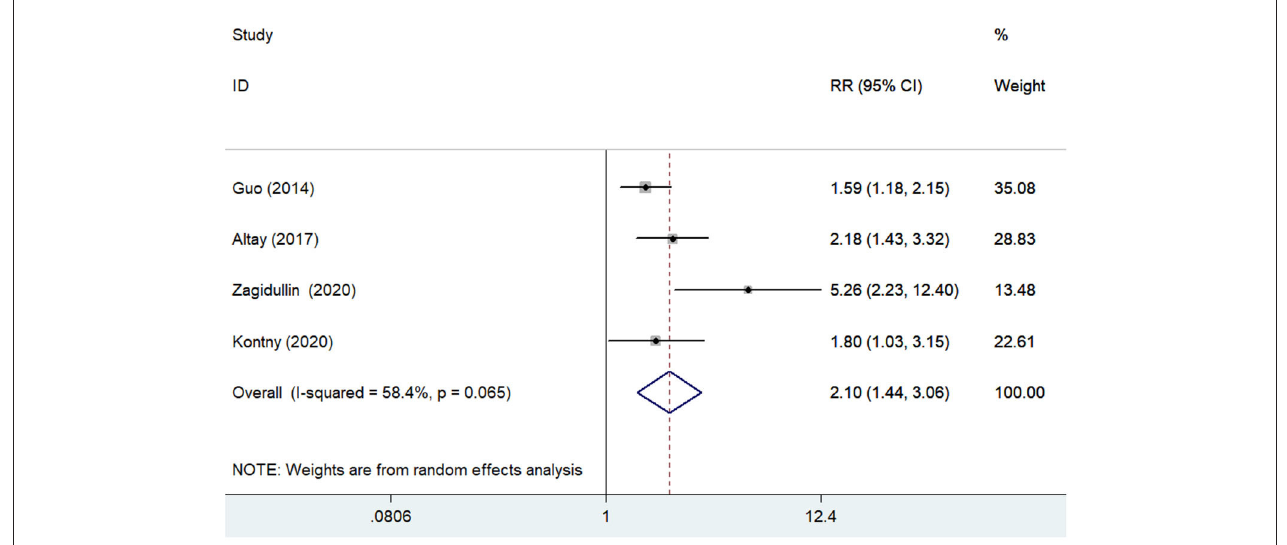
FIGURE 4 | Forest plots showing the pooled multivariate-adjusted RR and 95% CI of cardiovascular mortality for the highest pentraxin-3 level vs. the lowest pentraxin-3 level.